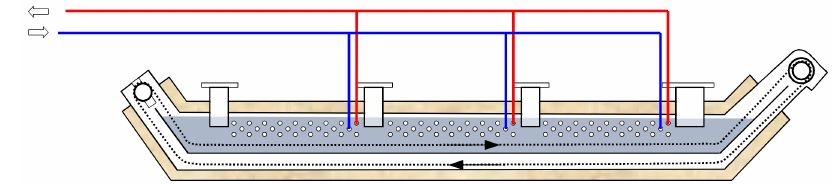
Figure 14. A direct slag waste heat recovery proposal.